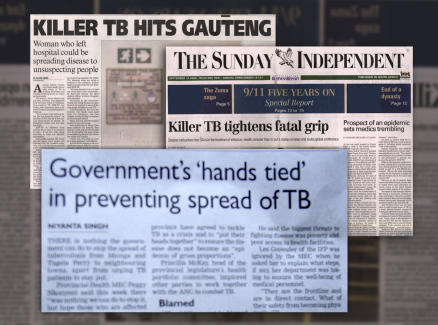
South African newspapers fuelled alarm about XDR-TB(figure: Anthony Flores)